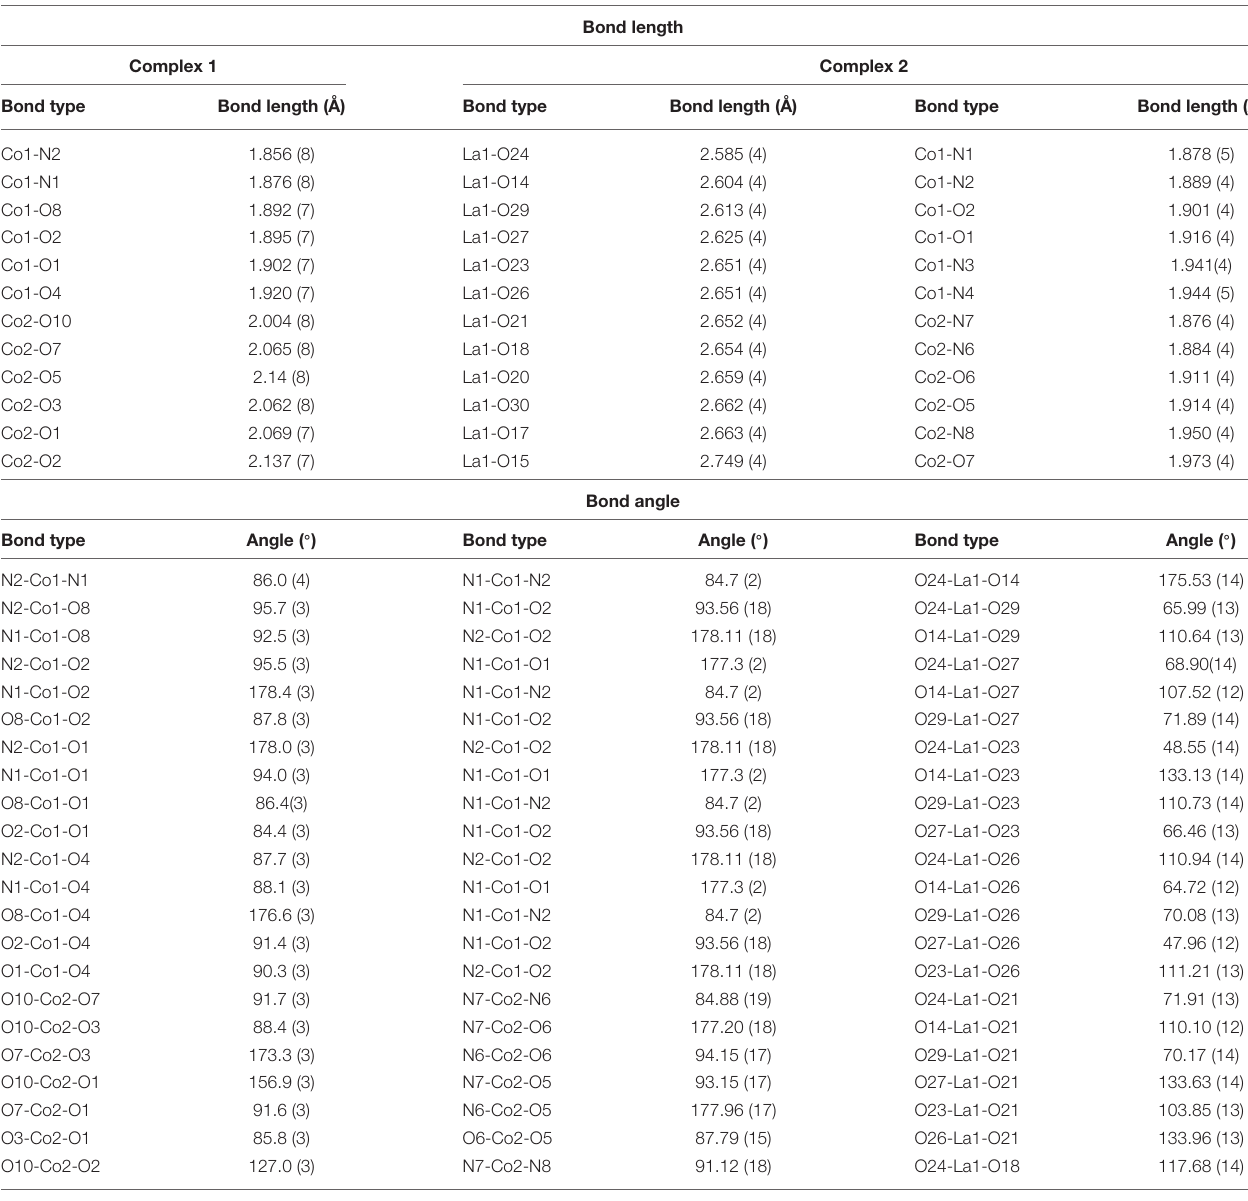
TABLE 2 | Selected bond distances (Å) and bond angles ( ◦ ) for complexes 1 and 2.